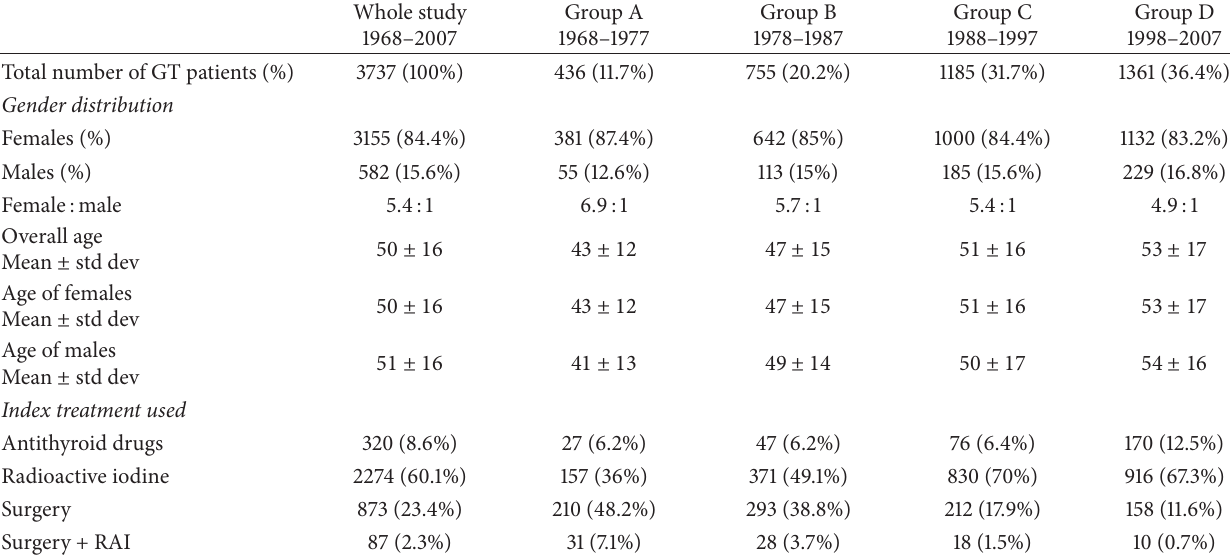
Table 1: Demographic characteristics and index therapy according to decades.